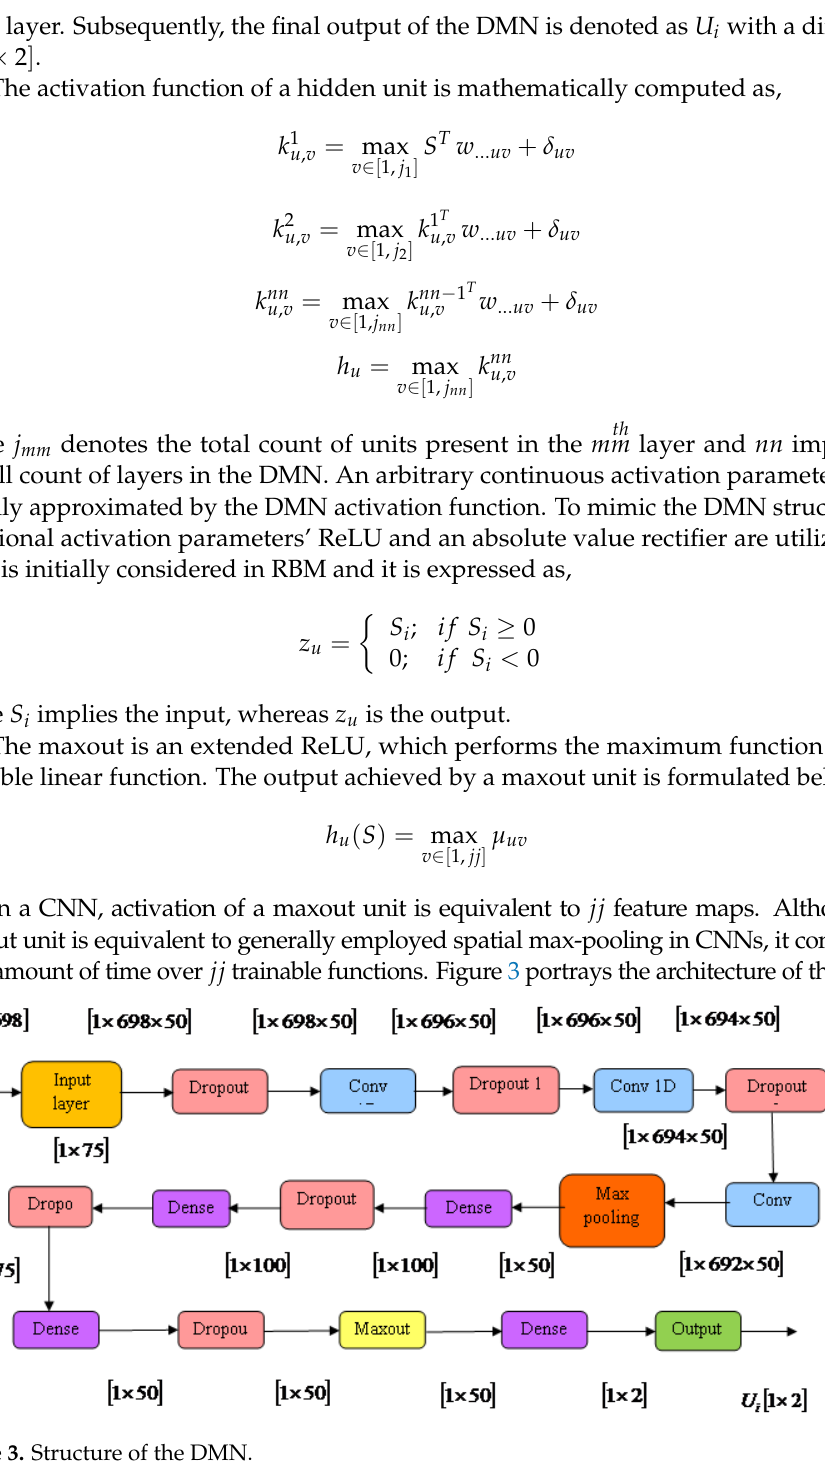
Figure 3. Structure of the DMN.